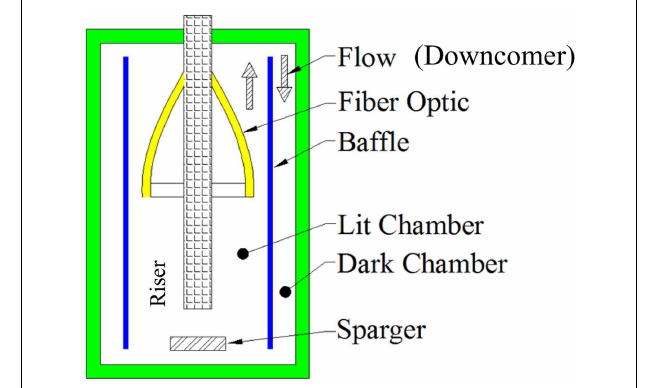
FIGURE 1 | Proposed air-lift bioreactor approach